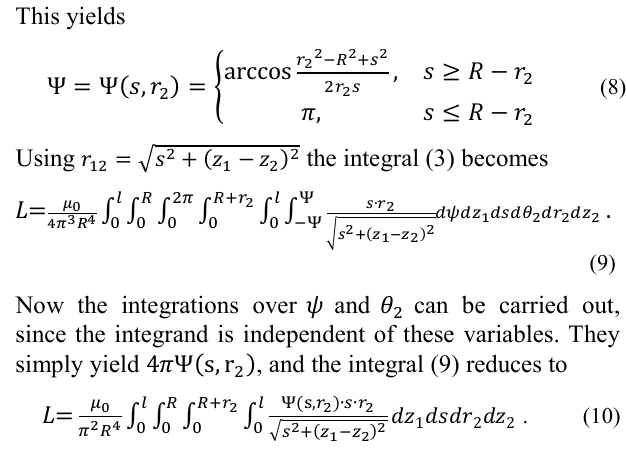
Figure 2: Polar coordinates ( ) for the projected inte- gration point . For constant , the angle varies between and